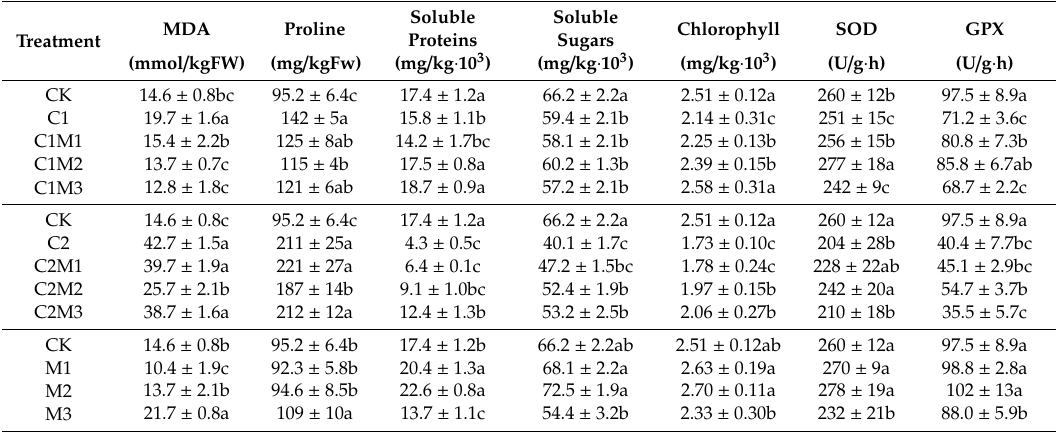
Table 2. Changes in leaf physiological parameters of rape plants with the co-treatment of Mo and Cd ( n =